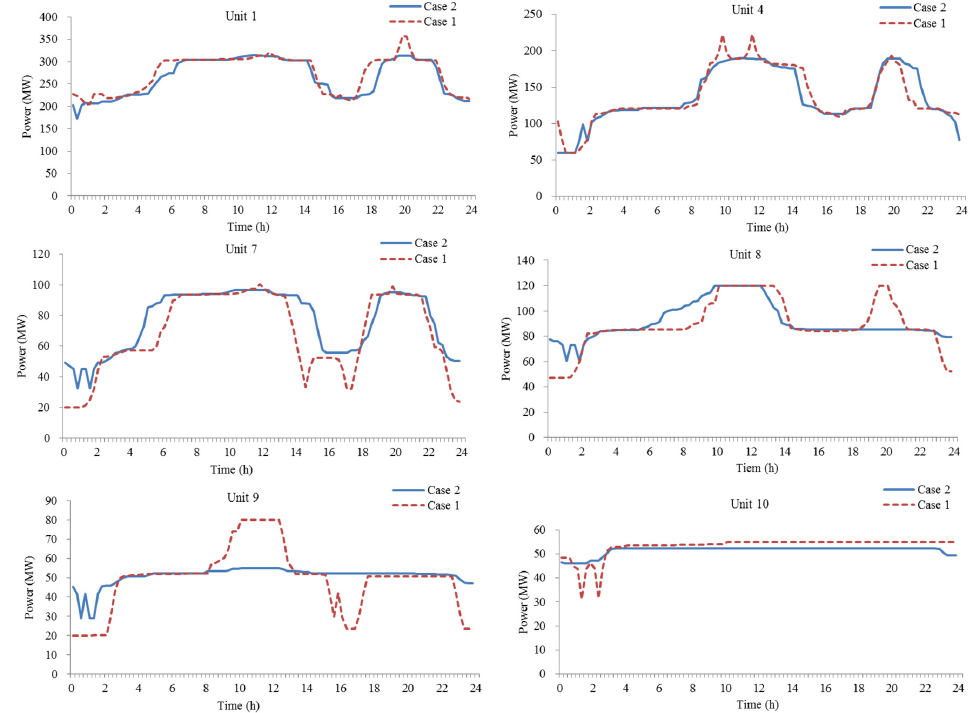
Figure 11. Active power generating curves of Unit 1, Unit 4 and Units 7–10 in Case 1 and Case 2 with 0.9 confidence degree.